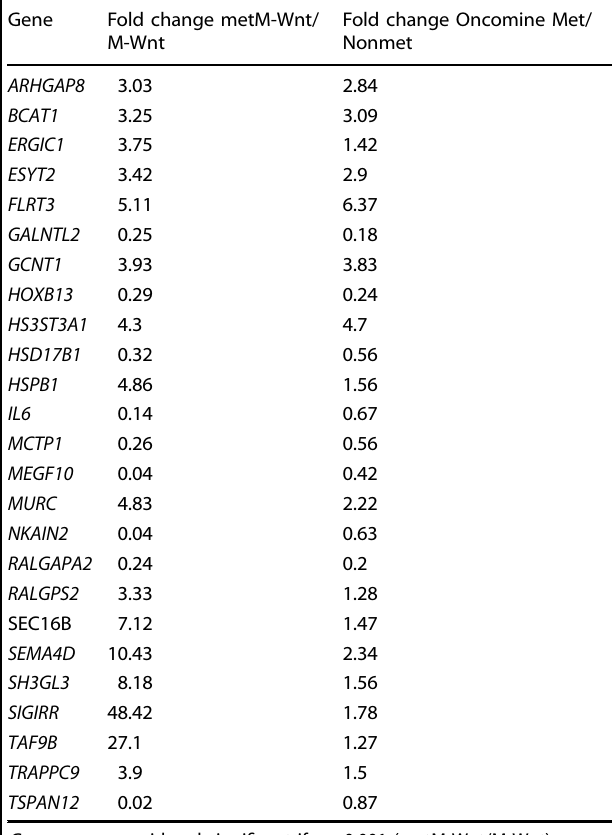
Table 2. List of genes concordant with available human breast cancer microarray datasets Gene Fold change metM-Wnt/